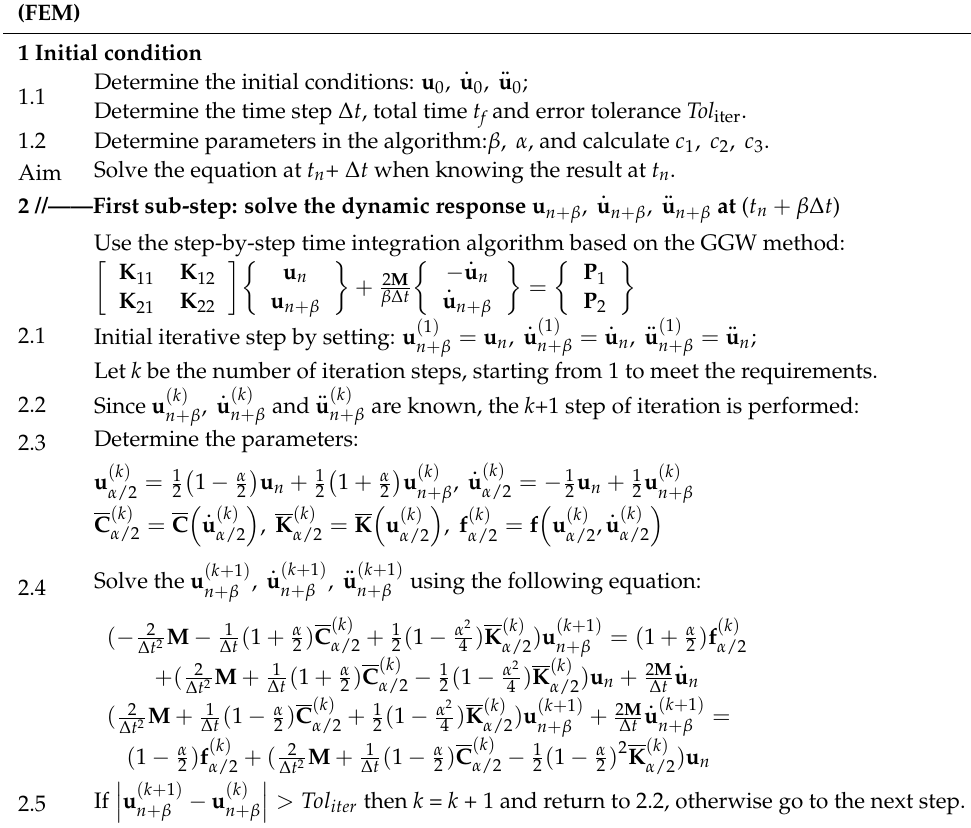
Algorithm 1. The proposed two sub-step method based on Galerkin Finite Element